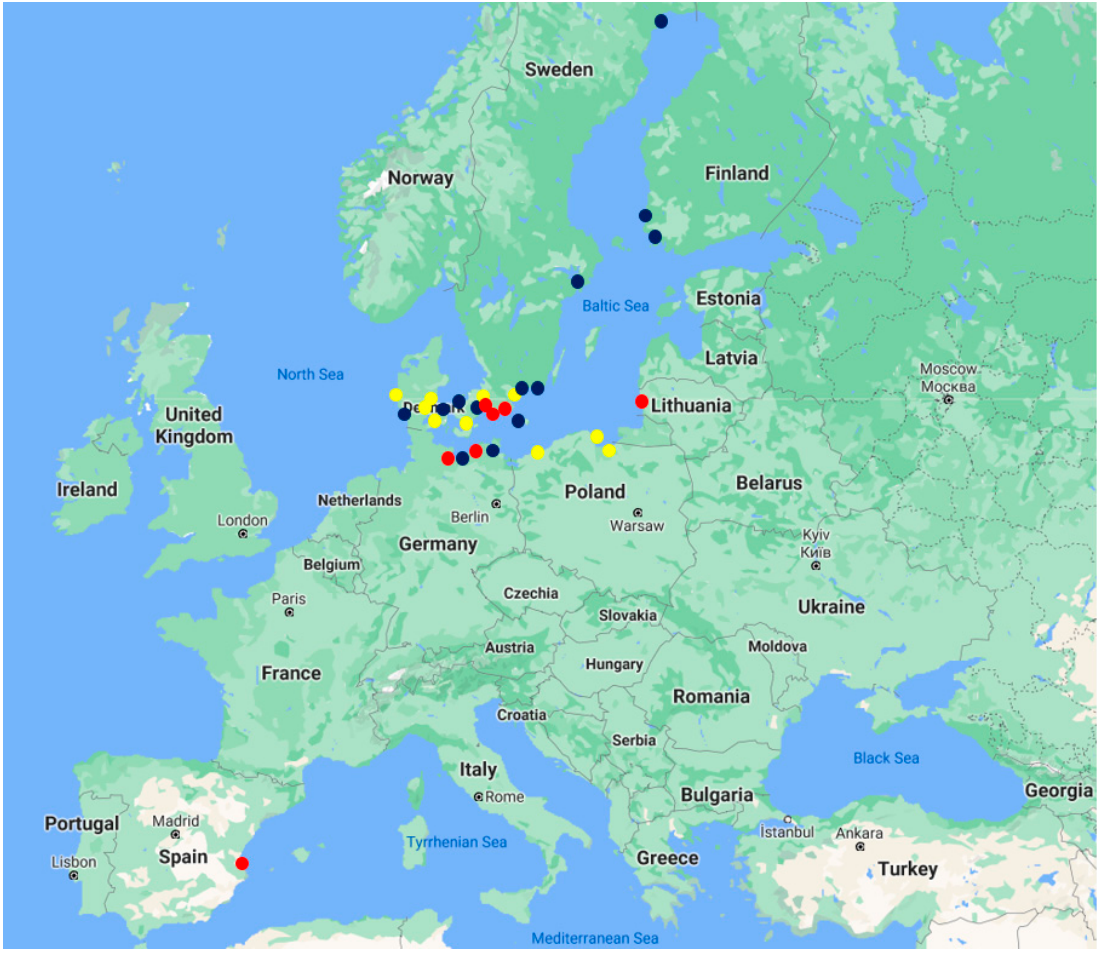
Figure 3. Location of analysed ports: small ports are coloured yellow, medium-sized ports blue and large ports red.